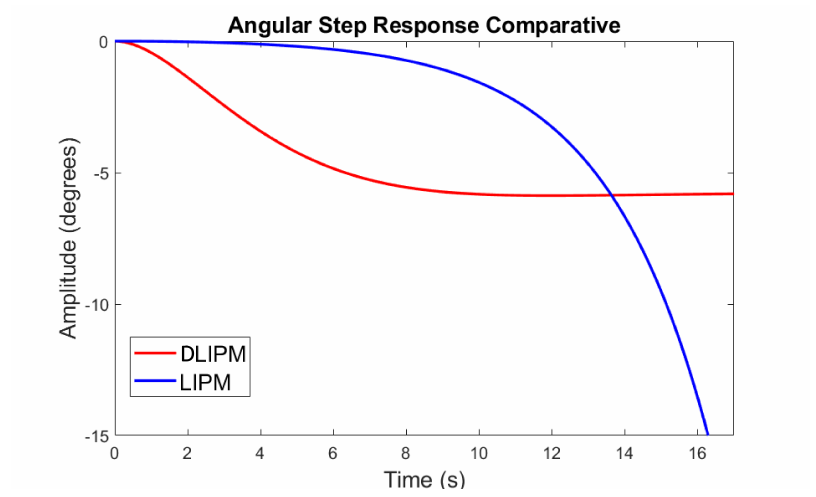
Figure 17. Angular step response for the LIPM and